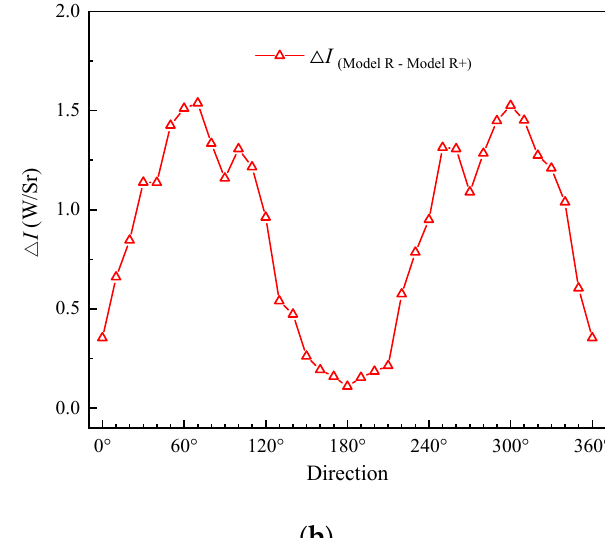
Figure 18. Infrared radiation intensity distribution of Model R and Model R+ in 3–5 µm band. ( a ) Infrared distribution characteristics; and ( b ) suppression value.